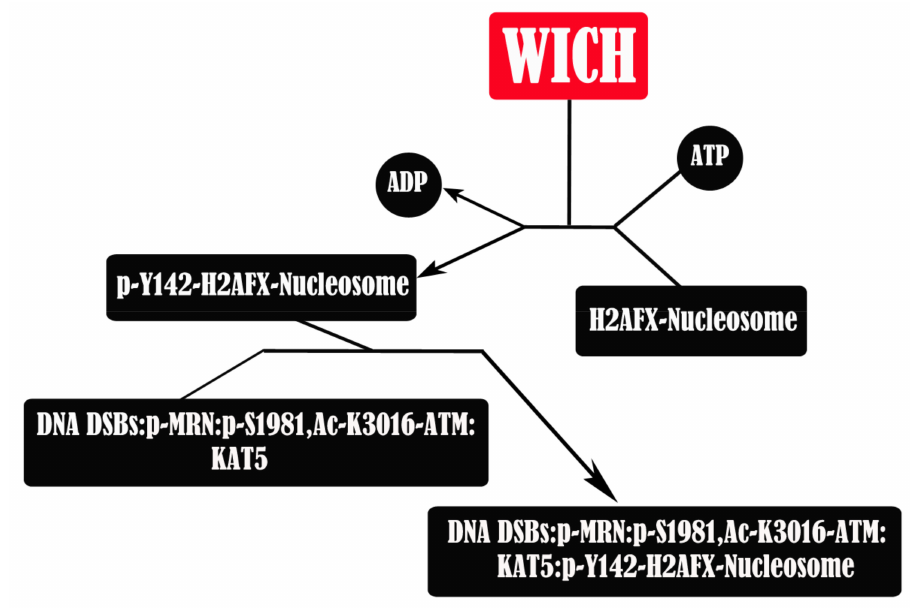
Figure 8. BAZ1B is involved in the recruitment and ATM-mediated phosphorylation of repair and signaling proteins at DNA DSBs. It phosphorylates H2AF on Tyr142. After DNA DSB induction, the MRN complex (Mre11, Rad50, and Nbs1) binds to the DNA breaks followed by ATM recruitment. ATM, in dimeric form, is in a complex with KAT5. KAT5 then acetylates ATM at DNA DSB. MRN activates ATM dimer by promoting its dissociation into monomers and then ATM phosphorylates the NBN (Nbs1) component of the MRN complex, resulting in the p-MRN:p-S1981,Ac-K3016-ATM:KAT5 protein complex at DNA DSB sites. This complex then recognizes and associates with the p-Y142-H2AFX-nucleosome. Phosphorylation of Ser139 and dephosphorylation of Tyr142 are the following steps. This nucleosomal complex will then undergo multiple modifications such as phosphorylation, methylation, and ubiquitination as well as binding of additional proteins and will eventually lead into nonhomologous end-joining (NHEJ) and homology-dependent repair through homologous recombination repair (HRR) or single strand annealing